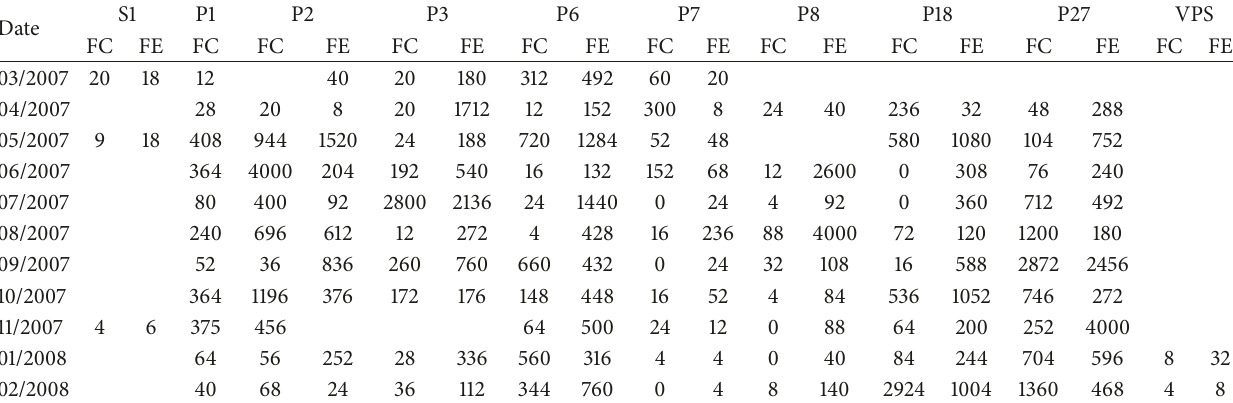
Table 4: Fecal coliforms (FC) and fecal enterococci (FE) detected in water samples. The values are expressed in